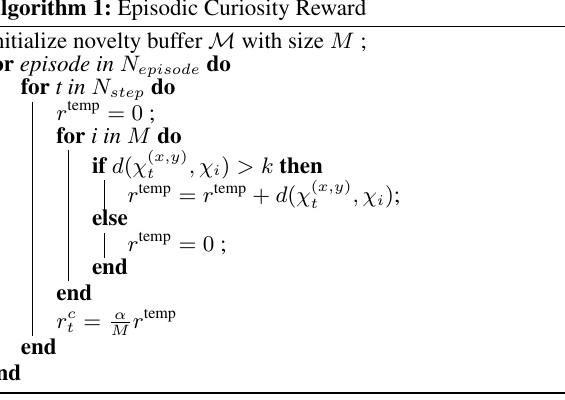
Algorithm 1: Episodic Curiosity Reward